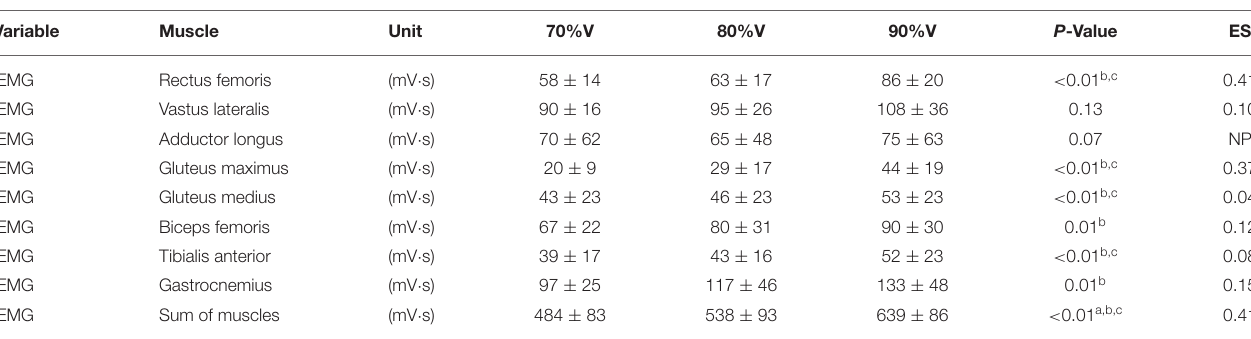
TABLE 3 | Results of iEMG for each muscle and sum iEMG in the 70, 80, and 90%V trials.